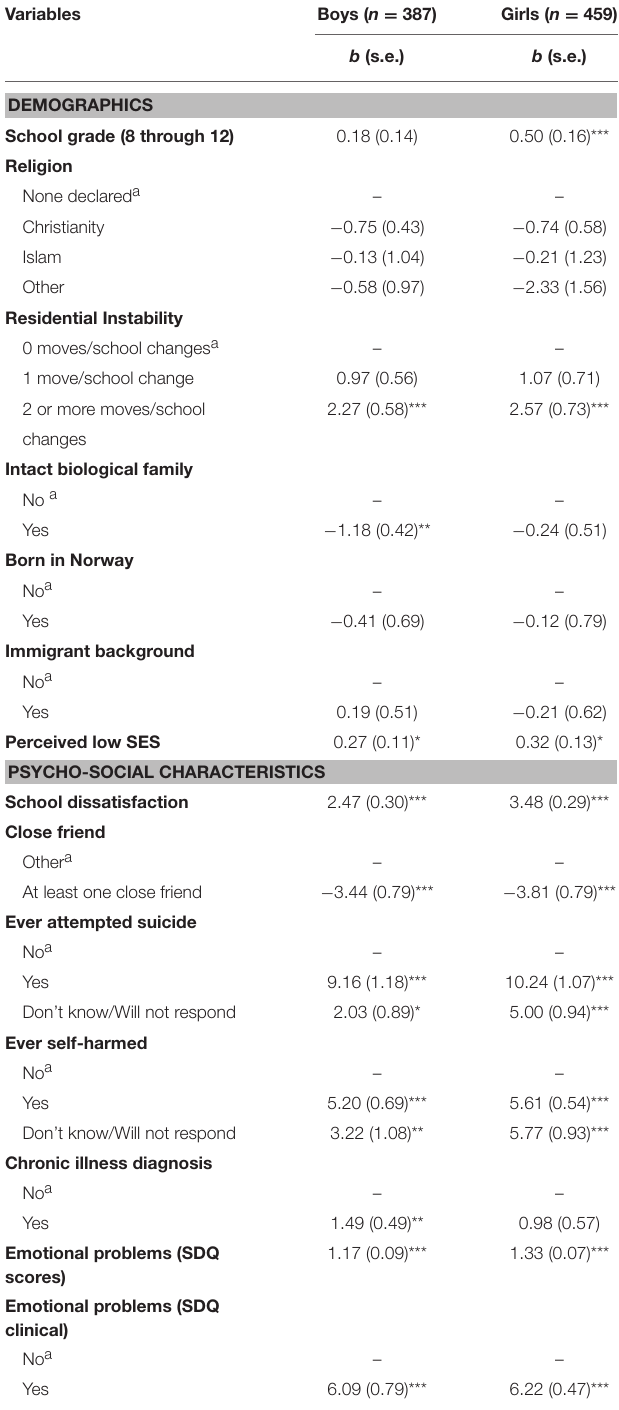
TABLE 6 | Adolescent depressive symptomatology as a function of psycho-social characteristics; crude associations by gender.